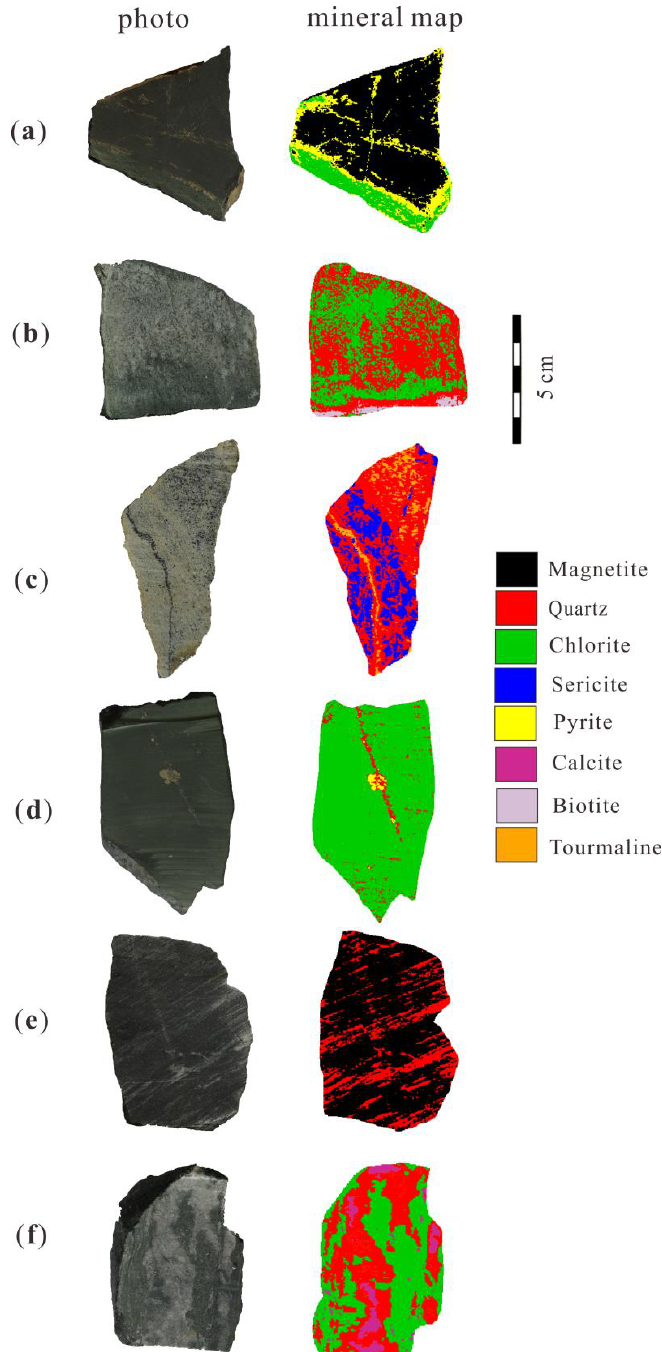
Figure 15. The result of hyperspectral mineral mapping: ( a ) the photo and mineral map of Q-2; ( b ) the photo and mineral map of Q-4; ( c ) the photo and mineral map of Q-9; ( d ) the photo and mineral map of Q-11; ( e ) the photo and mineral map of Q-12; ( f ) the photo and mineral map of Q-13.